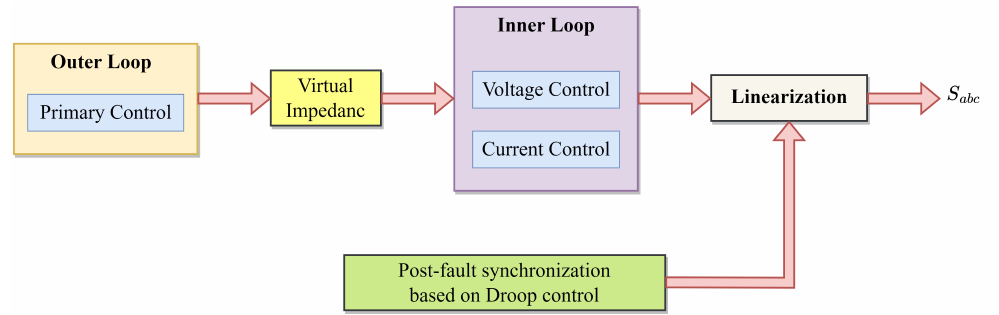
Figure 29. Grid-forming control structure in